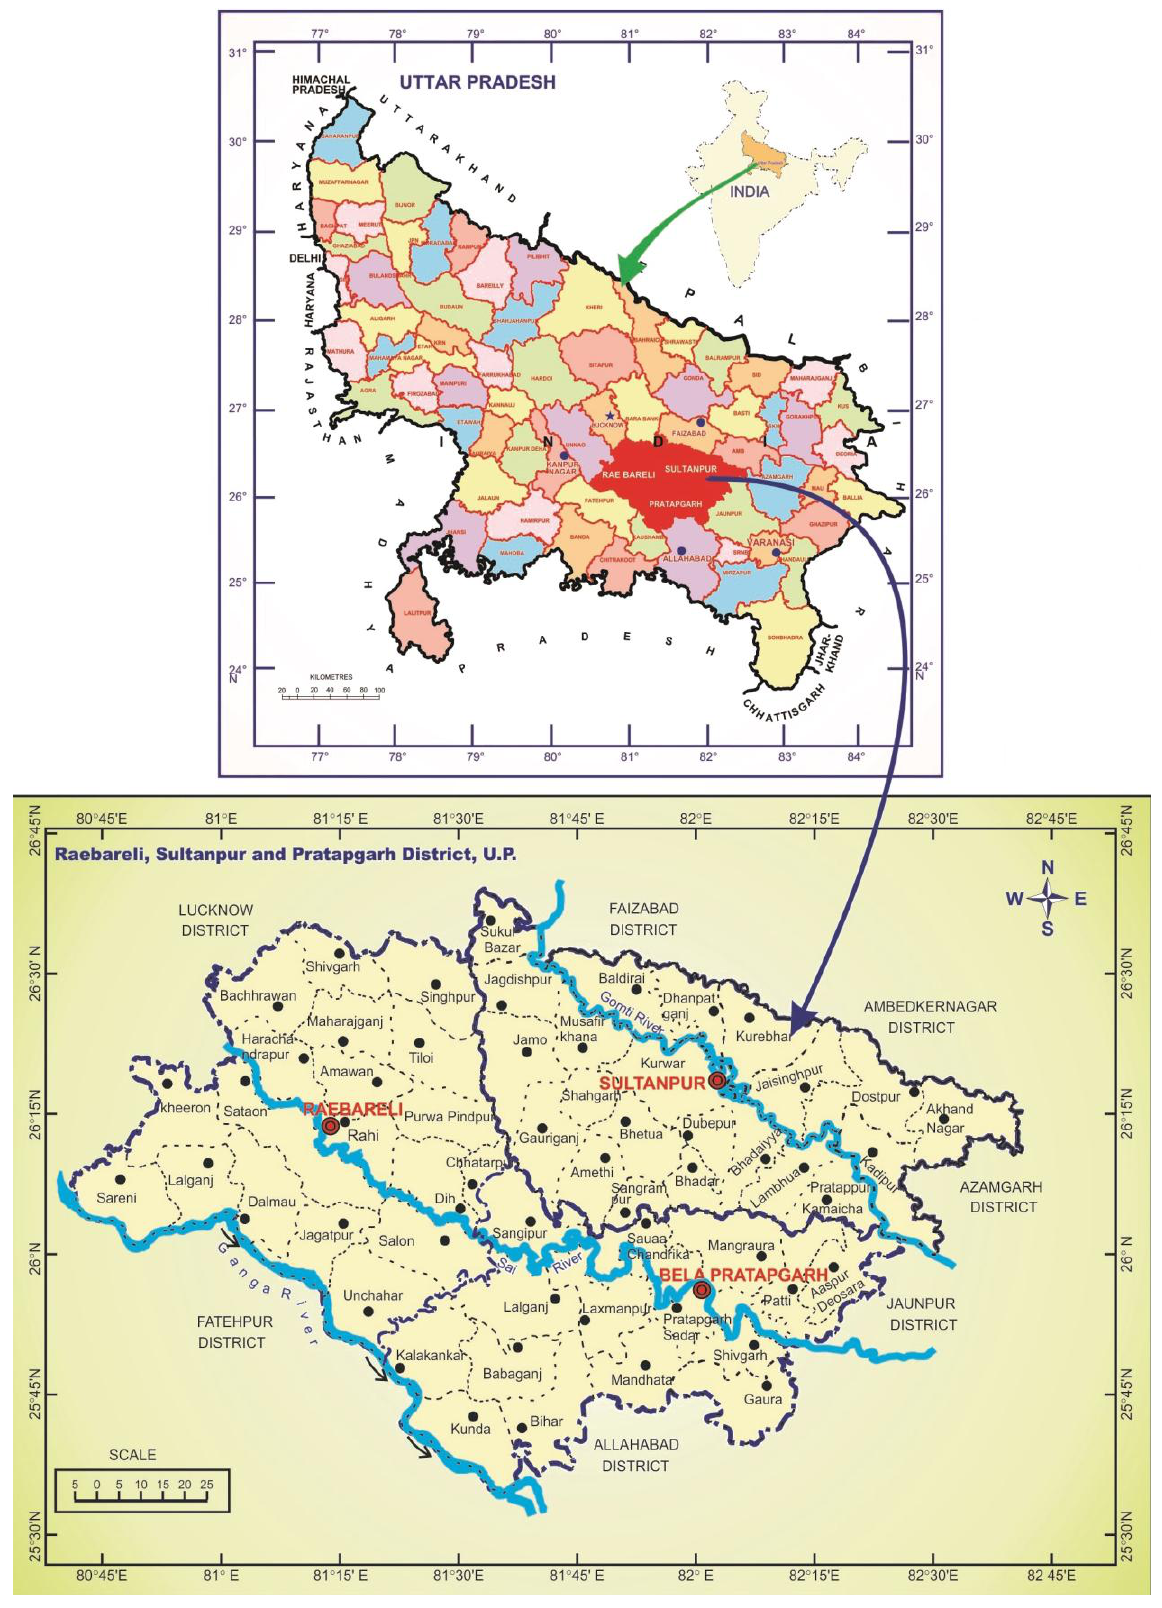
Fig. 1. Location of the study